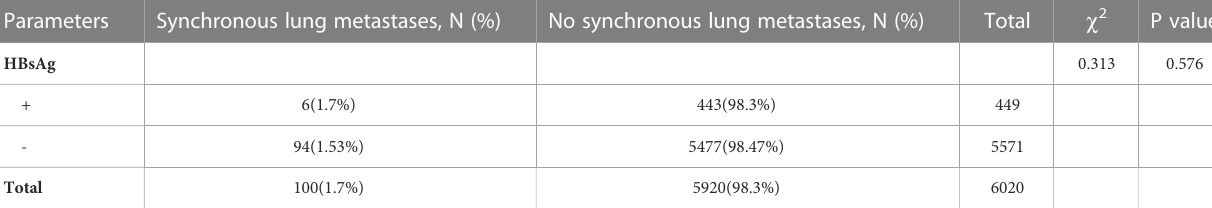
TABLE 5 In fl uence of HBsAg status on lung metastasis.